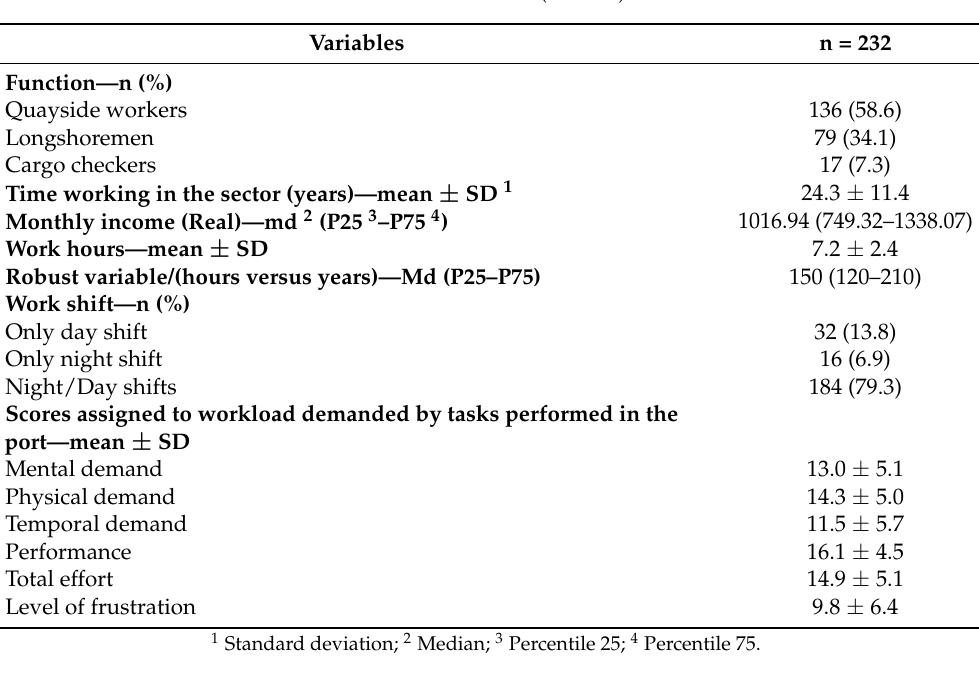
Table 2. Work data (n = 232).